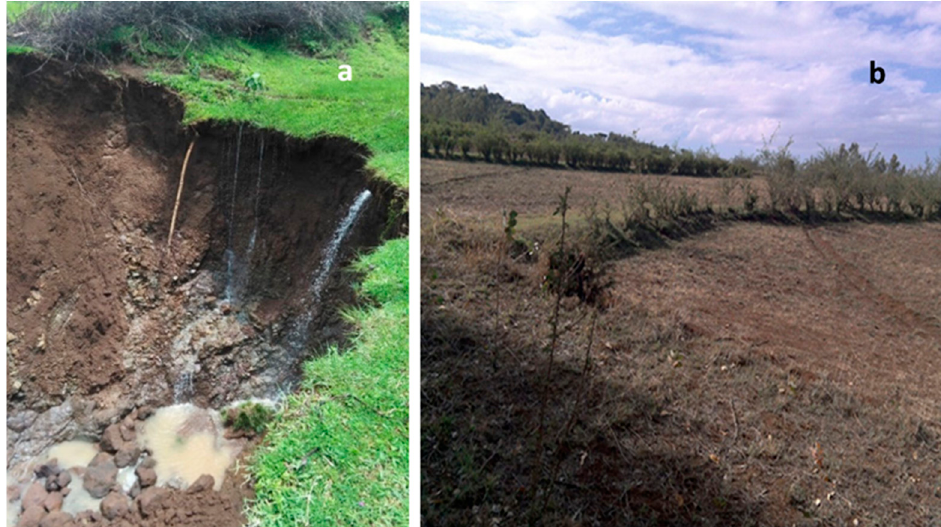
Figure 3. Photos depicting features in the Debre Mawi watershed: ( a ) Five-meter deep gully in the saturated bottomland of the Debre Mawi watershed. ( b ) Bund with Sesbania grandiflora in 2017. The bund, together with the infiltration furrow, was constructed in 2012. The infiltration furrow was filled with sediment in 2018 and is not visible.